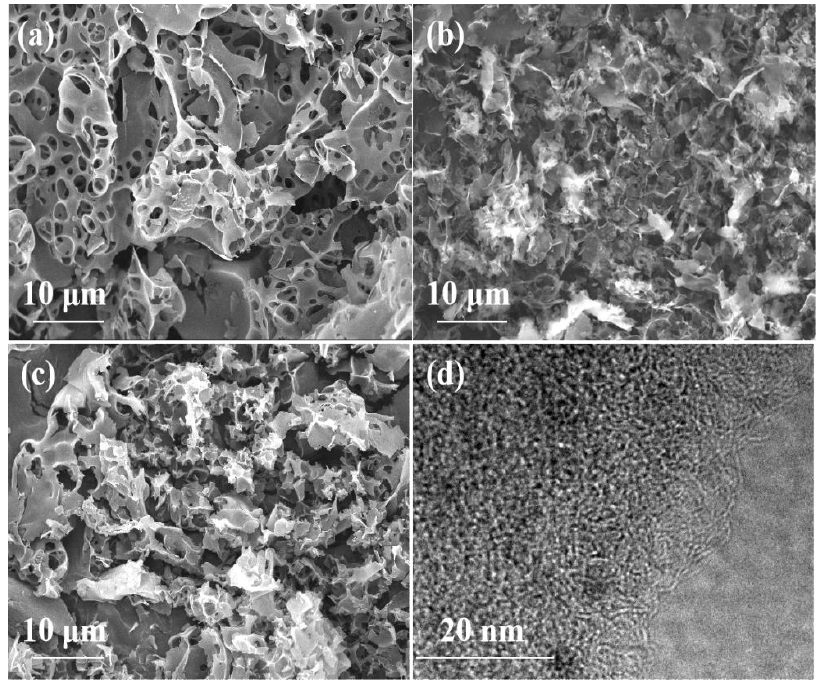
Figure 2. Field emission (FE)-SEM images of PC1 ( a ), PC2 ( b ), and PC3 ( c ) with low magnifications; TEM image of PC1 ( d ) with high magnifications. PC: porous carbon. Nanomaterials 2019 , 9 , x FOR PEER REVIEW